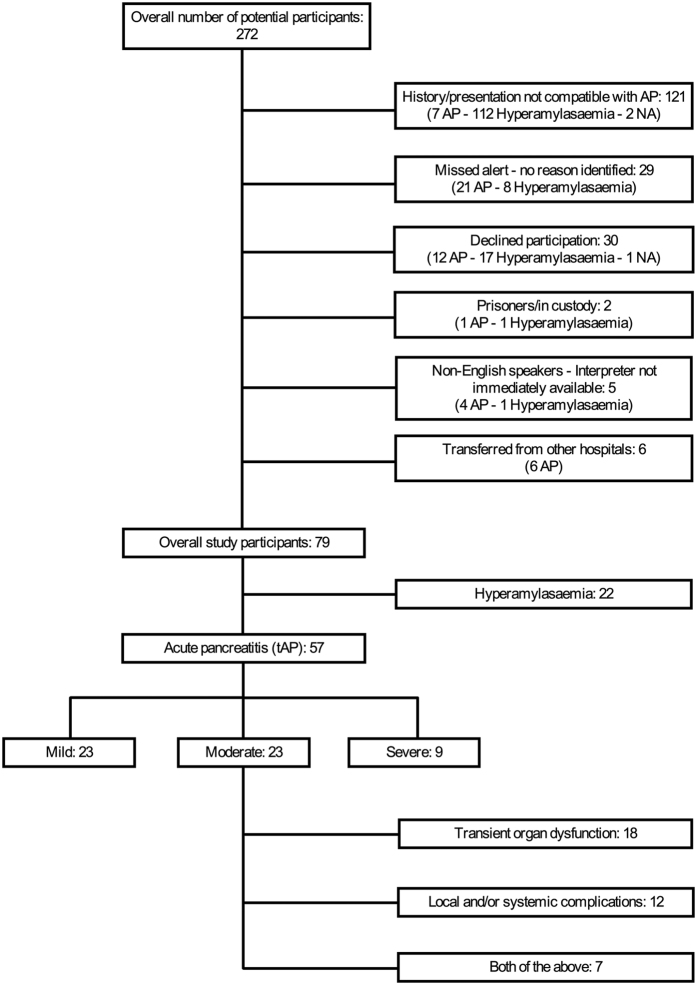
CONSORT diagram of the IMOFAP study.Reasons for patient exclusion are summarised, with post-hoc diagnoses for each exclusion category included in brackets (NA = not available). Patients of the moderate AP severity group were divided to three further sub-groups according to the revised Atlanta guidelines for explanatory purposes.